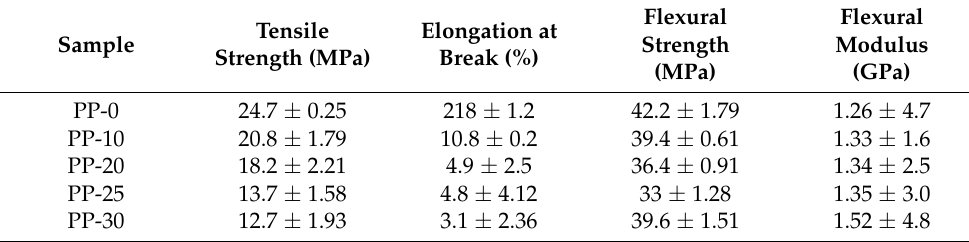
Table 5. Tensile and flexural properties of the